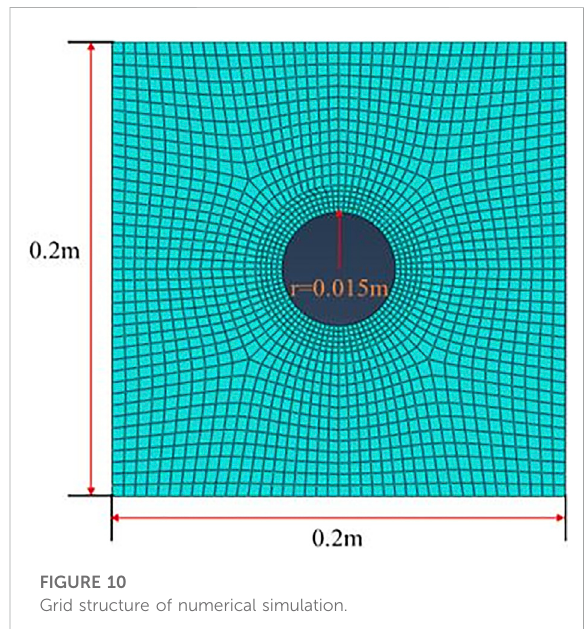
FIGURE 10 Grid structure of numerical simulation.